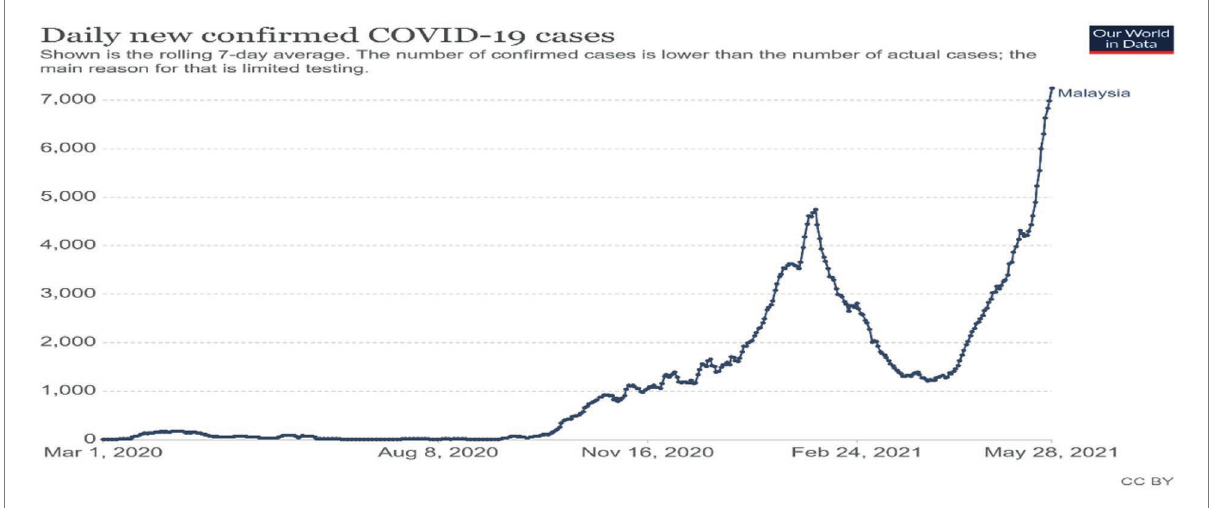
FIGURE 1 Reproduced under CC-BY-4.0. Our World in Data, COVID-19 Data Explorer - Our World in